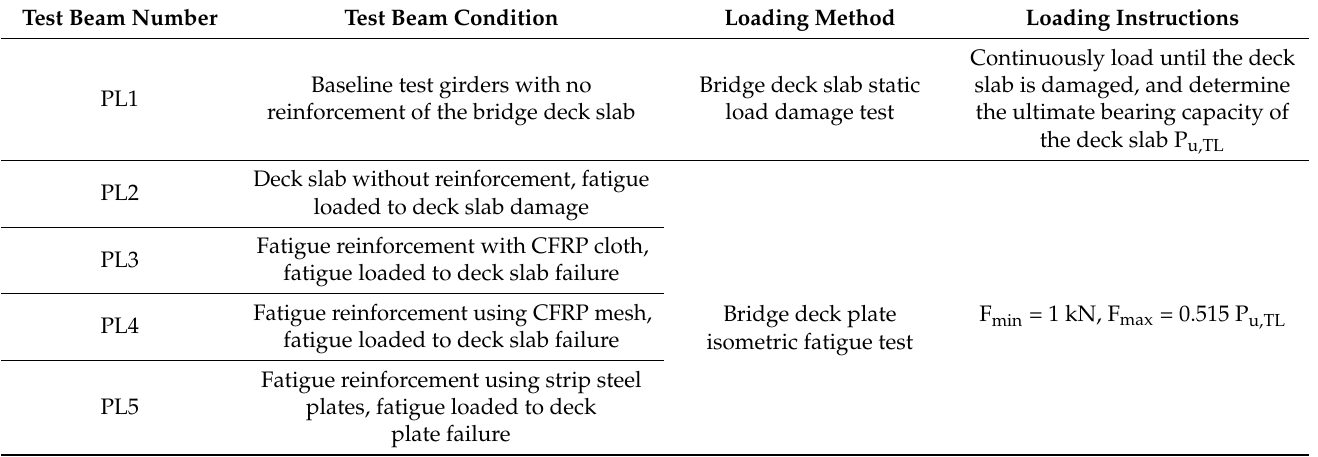
Figure 3. Bridge deck slab reinforcement. Table 3. Test beam